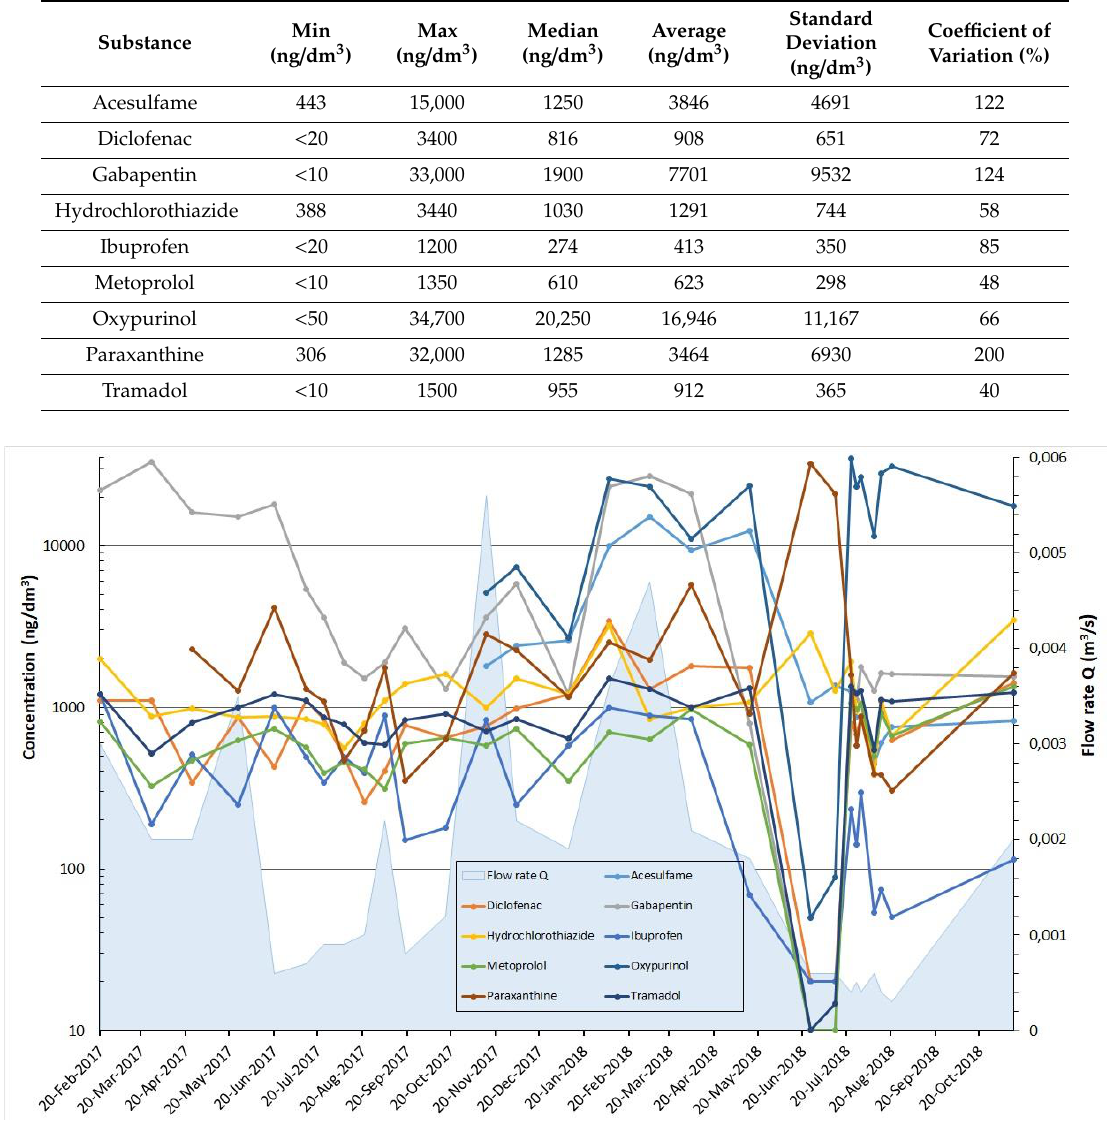
Figure 3. Monitoring results on Hnevkovice profile.